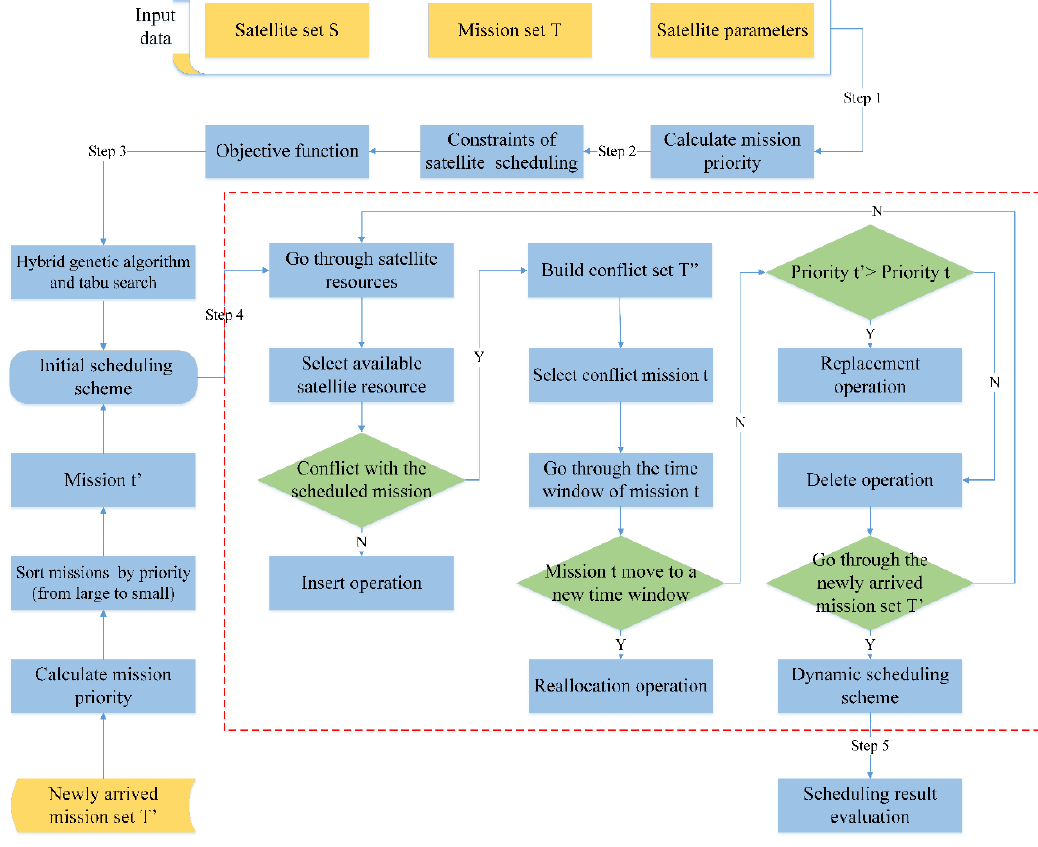
Figure 1. Flow chart of a multi-satellite dynamic mission scheduling model based on mission priority under emergency conditions.